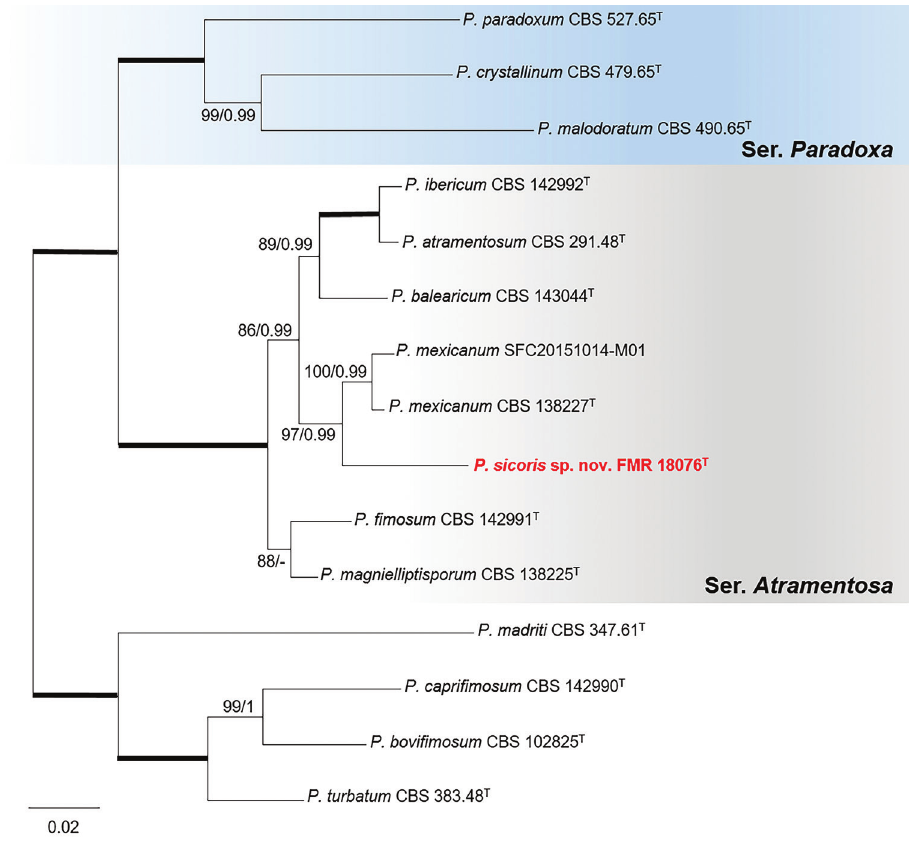
Figure 3. Phylogenetic tree of Penicillium section Paradoxa based on ML analysis obtained by RAxML inferred from the combined tub 2, cmdA , ITS, and rpb 2 loci. Branch lengths are proportional to phylogenetic distance. Bootstrap support values/Bayesian posterior probability scores above 70%/0.95 are indicated on the nodes. Bold branches indicate bs/pp values 100/1. The tree is rooted to Penicillium species belonging to section Turbata ( P. madriti CBS 347.61, P. caprifimosum CBS 142990, P. bovifimosum CBS 102825 and P. turbatum CBS 383.48). The name in red is the new species described in this study. T = Ex-type